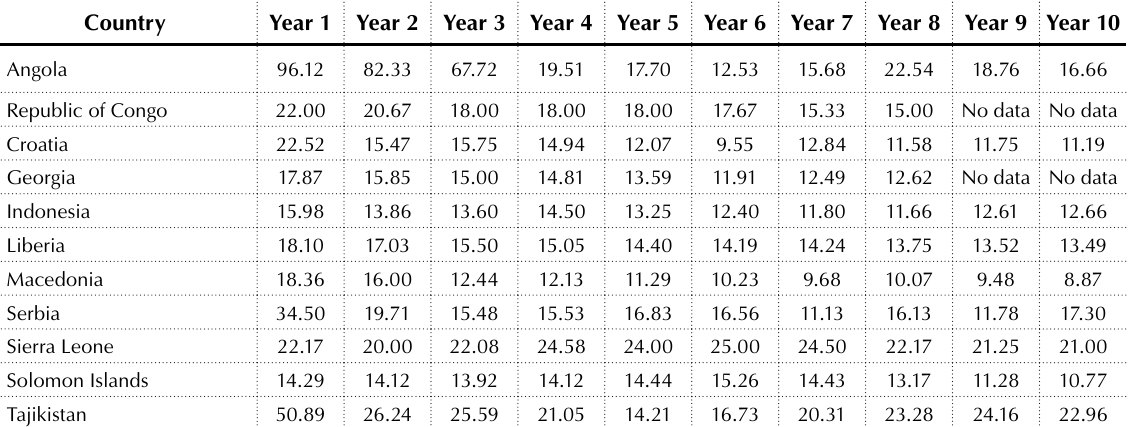
Source: World bank Open Data.